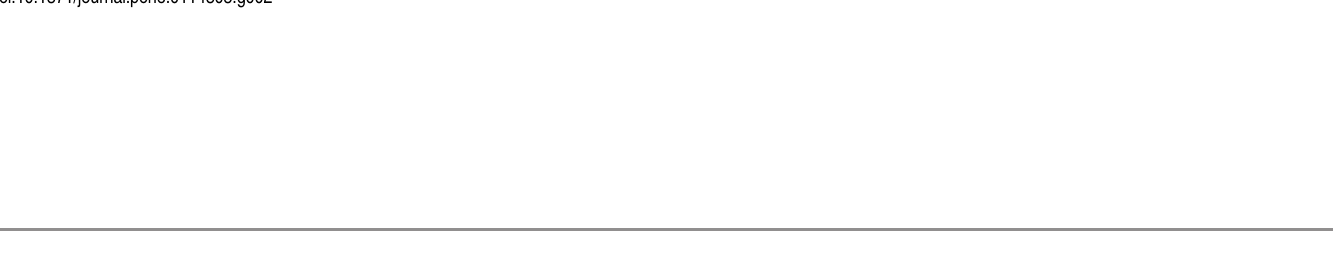
Figure 2. Comparison of the effectiveness of eCG and AIS treatments for superovulation. Strains that responded better to eCG than to AIS are indicated with white circles, and those that responded better to AIS than eCG are indicated with black diamonds. For MSM and JF1, the ratio was calculated from the date reported previously [13]. Other strains without data for eCG (Figure 1) are omitted from this figure. (A) Scatterplots displaying the comparative effectiveness of superovulation with eCG and AIS. The strains are grouped by ovals representing the subspecies so that the subspecies-specific tendencies can be observed. There was a significant effect of the superovulation regimen on the numbers of oocytes collected in M. m. molossinus , M. m. domesticus , and M. m. spp (Table 2). (B) A world map showing the place of origin of wild-derived strains. There was a trend that strains from Asia were more AIS- sensitive and those from Europe and the North America were more